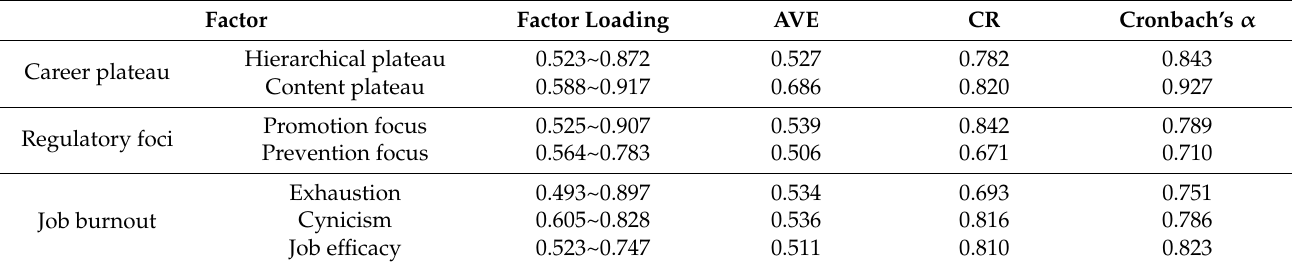
Table 2. Reliability and validity.